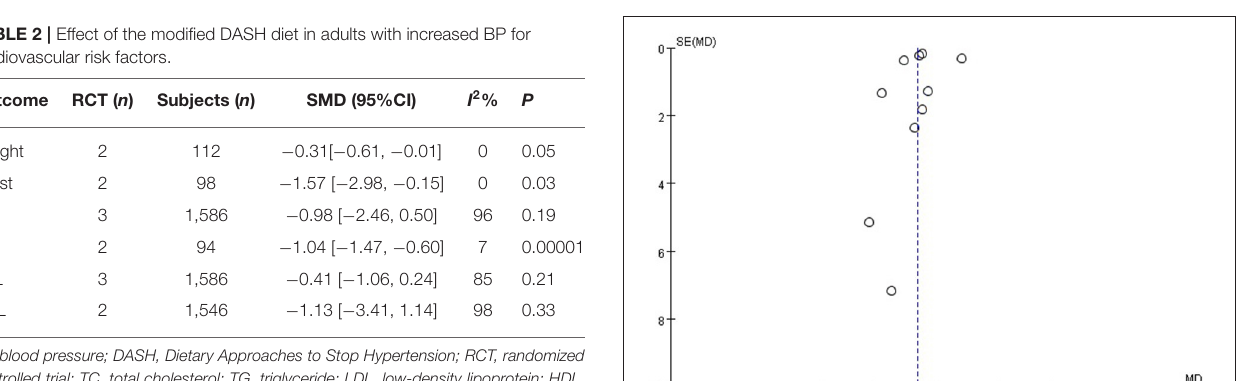
contradicted with our study findings. Most studies